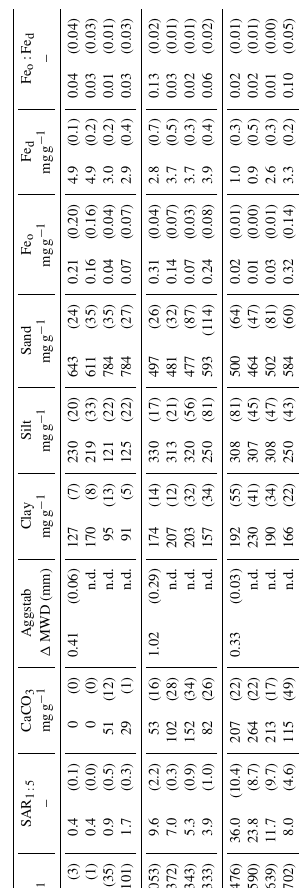
Figure 4. The 14 C activity (pMC) for three soil types and two OM fractions as a function of soil depth. Rectangles on the left of each panel indicate diagnostic horizons. Due to low quantity of LF ma- terial in the subsoil, 14 C activities were only analyzed until the top- most C horizon. Abbreviations: LF is light fraction, HF is heavy